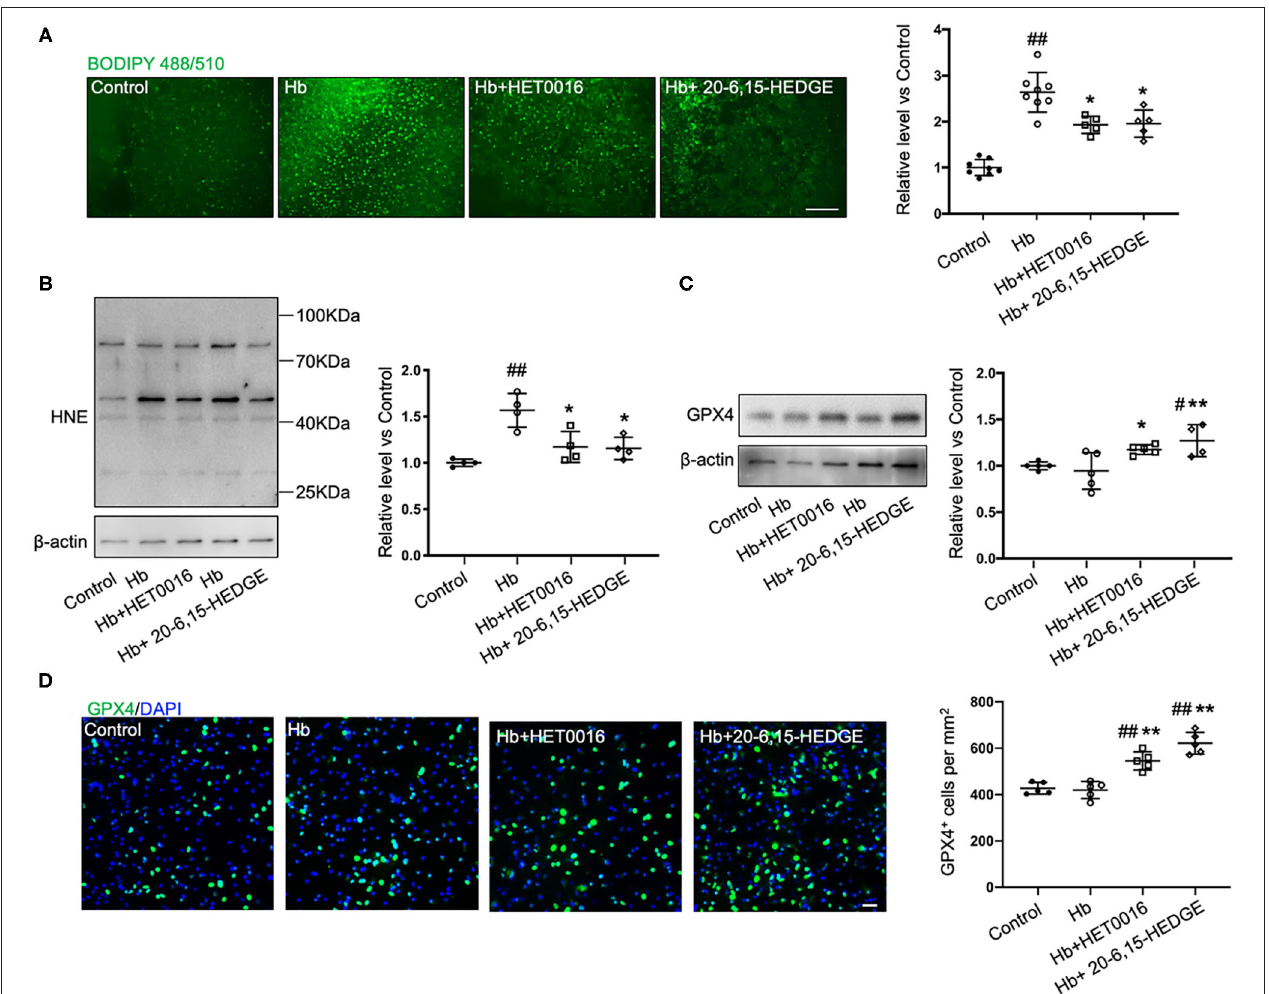
FIGURE 2 | 20-HETE promotes ferroptosis in ex vivo ICH model. Organotypic hippocampal slice cultures (OHSCs) were exposed to 10 µ M hemoglobin (Hb) with or without 10 µ M HET0016 or 10 µ M 20-6,15-HEDGE. (A) Lipid peroxidation level was detected with BODIPY 581/591 C11 reagent 6h after incubation with different reagents. Representative fluorescent images and fluorescent intensity quantification relative to control slices showed an increased lipid peroxidation state with Hb exposure that was attenuated by HET0016 or 20-6,15-HEDGE co-treatment. Scale bar is 200 µ m. n = 5–8 slices/group. (B,C) Western blotting of OHSC total protein extract was carried out to assess the level of 4-hydroxy-2-nonenal (4-HNE) adducted protein (B) and glutathione peroxidase (GPX) 4 (C) 18h after incubation with different reagents. The expression was normalized relative to the control group. 20-HETE inhibition decreased 4-HNE adducted protein level and increased GPX4 expression. n = 4–5 from at least 20 slices/group. (D) Immunofluorescence result of GPX4 expression at 18h after exposure to different reagents in fixed slices. Bar is 30 µ m. n = 5 slices/group. # P < 0.05, ## P < 0.01 vs. Control group; * P < 0.05, ** P < 0.01 vs. Hb group. One-way ANOVA followed by appropriate post hoc test was applied. Data are expressed as mean ±